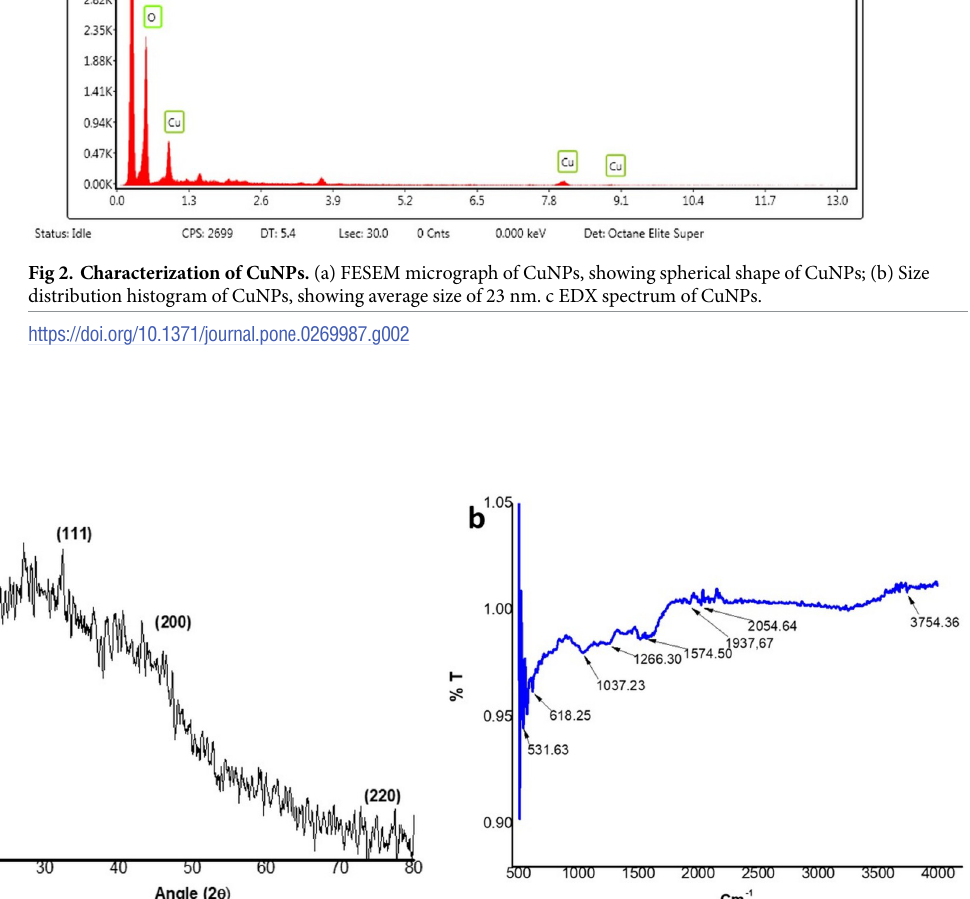
PLOS ONE | https://doi.org/10.1371/journal.pone.0269987 June 21,